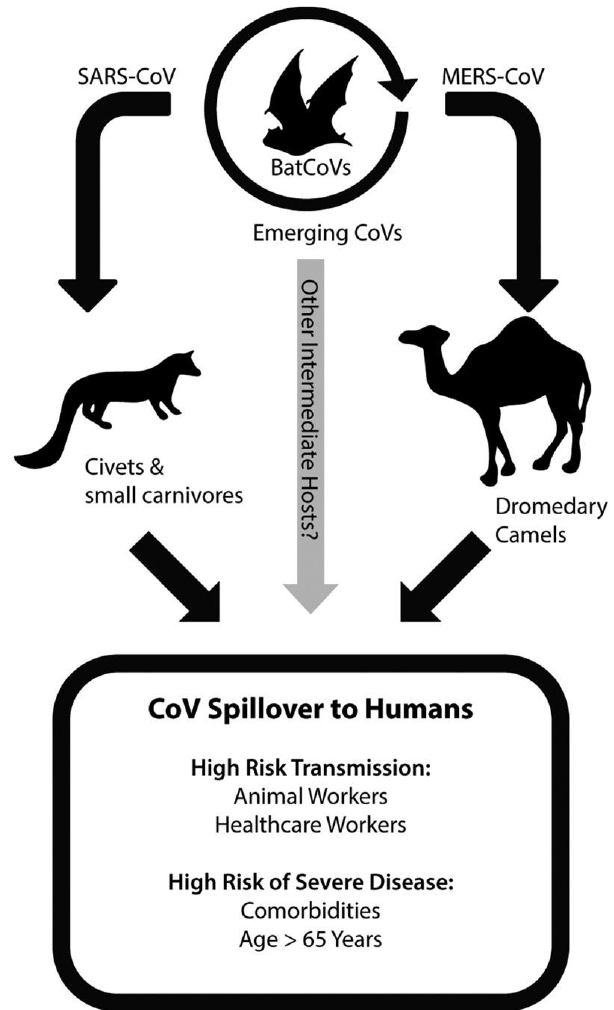
Figure 1: Courtesy of reference number 5. Coronavirus emerges from zoonotic reservoirs. Emergence of coronaviruses into human populations, including highly pathogenic viruses like SARS-CoV and MERS-CoV, has occurred by spillover from bat reservoir hosts into intermediate hosts. The intermediate hosts during the 2003 SARS-CoV epidemic included civets and other small carnivore species located in wet animal markets. MERS-CoV has been identified in dromedary camels, and is particularly associated with active infection of juvenile camels. Novel emerging CoVs may occur in the future via infection from bat populations into other intermediate animal hosts. Additional evidence from BatCoVs indicates that pre-emergent CoVs with the ability to directly infect human cells may be poised for emergence into human populations. Based on prior research from SARS and MERS outbreaks, animal workers that have